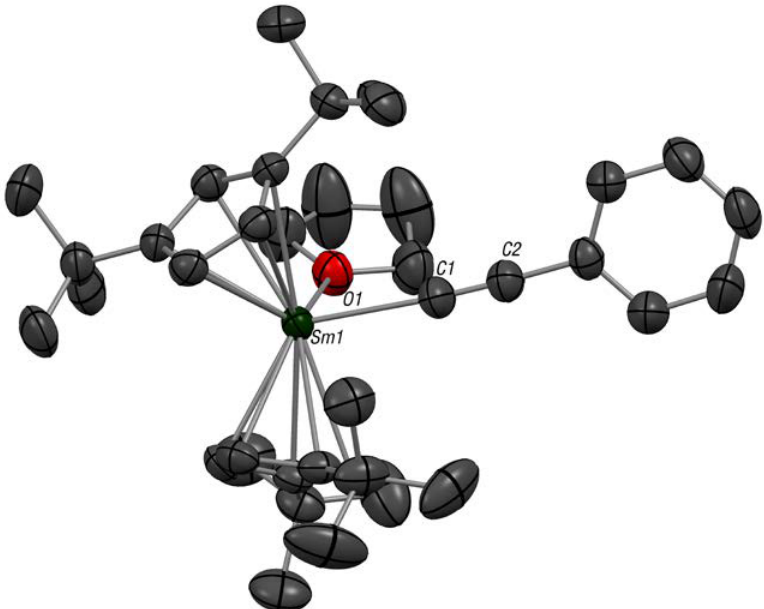
Figure 1. ORTEP (Oak Ridge Thermal Ellipsoid Plot) of 1 . Thermal ellipsoids are set to 50% probability level; H-atoms have been removed for clarity. Selected distances (in Å): Sm1–ctr